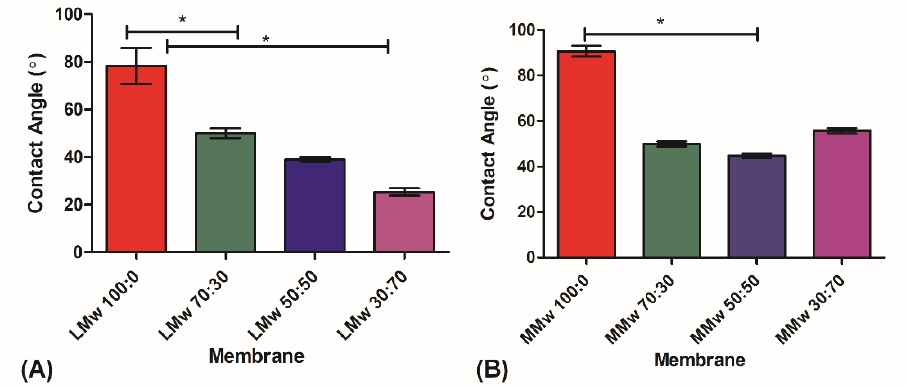
Figure 6. Water contact angle analysis of ( A ) LMw and ( B ) MMw neat and composite membranes 70:30. 50:50 and 30:70. The graphs show mean ± SD ( n = 3), (*) indicates statistically significant difference. LMw 100:0, 78° ± 6; LMw 70:30, 50°± 1.6; MMw 90° ± 3; MMw 30:70, 55° ± 1.6; MMw 50:50, 45° ± 1.